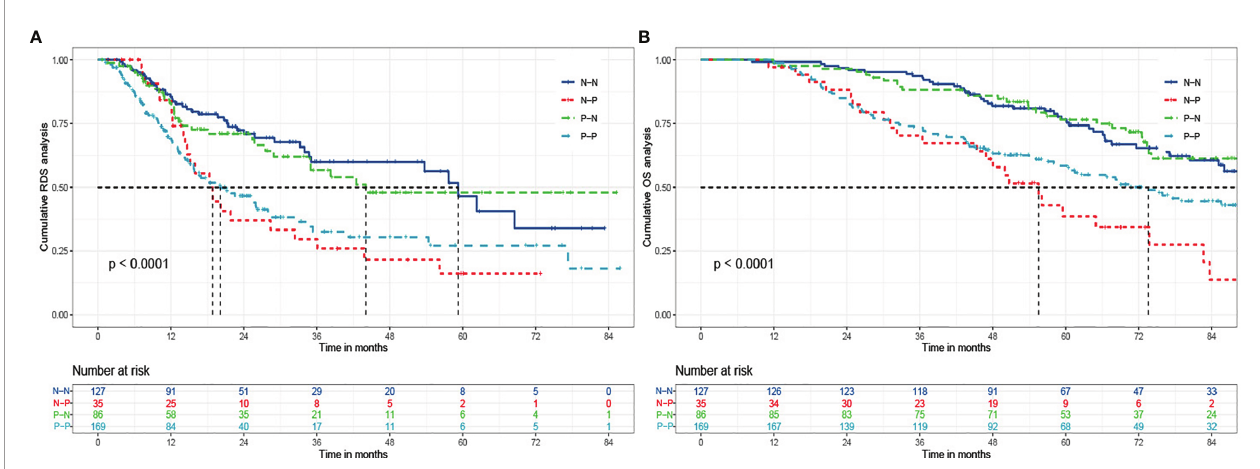
FIGURE 3 | The Kaplan-Meier analysis of RDS and OS for patients based on AFP alteration. (A) is the Kaplan-Meier analysis of RDS; (B) is the Kaplan-Meier analysis of OS. RDS, recurrence-death survival; OS, overall survival; N-N, negative AFP at baseline and negative AFP at relapse; N-P, negative AFP at baseline and positive AFP at relapse; P-N, positive AFP at baseline and negative AFP at relapse; P-P, positive AFP at baseline and positive AFP at